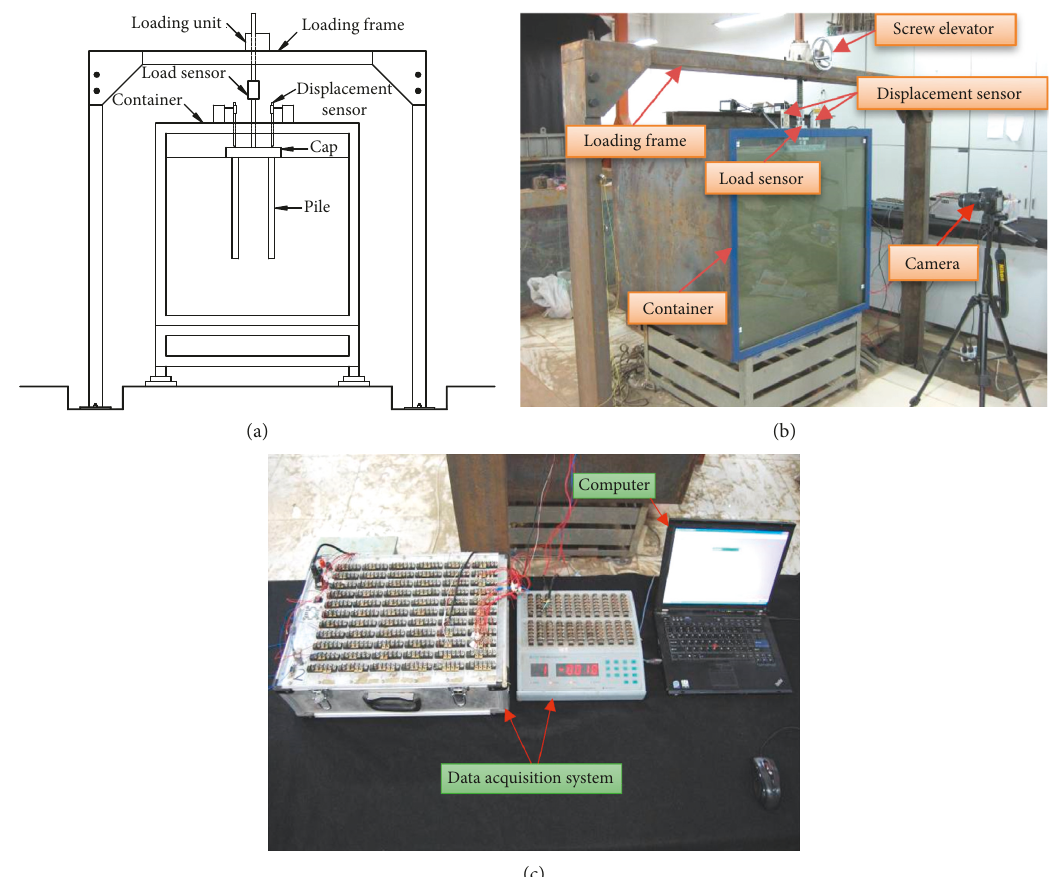
Figure 1: Test setup. (a) Schematic diagram of the test apparatus. (b) Model container and reaction frame. (c) Data acquisition